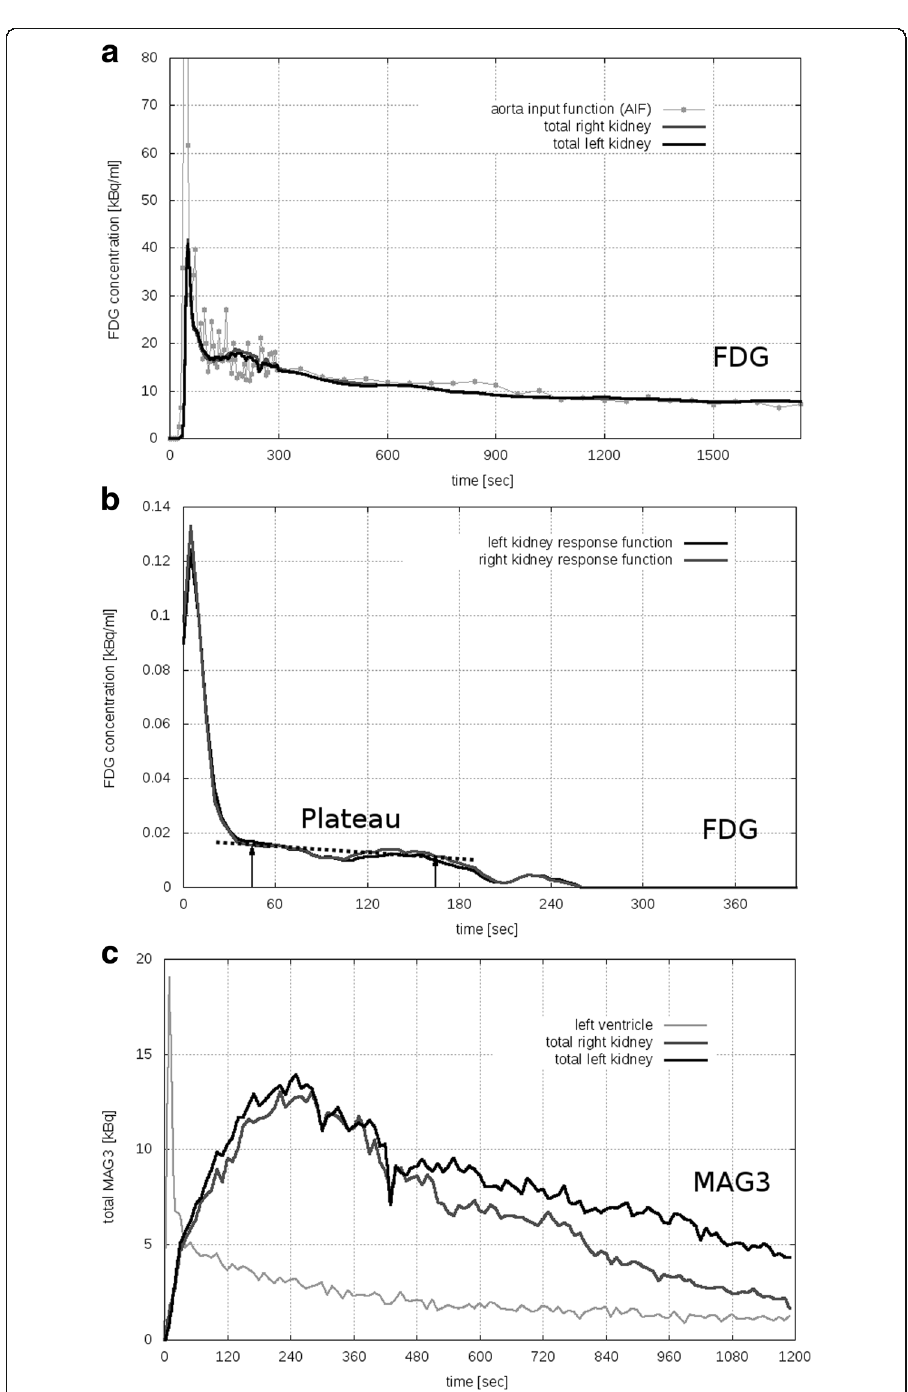
Fig. 2 Time-activity curves. a Typical FDG time-activity curves (TAC) of total left and right kidney and aorta input function (AIF). For the sake of visibility, the AIF peak is cut off (maximum at 201kBq/ml). b FDG response function of the total left and right kidney. c Background corrected MAG3 TACs of left and right kidney and the input function from the left